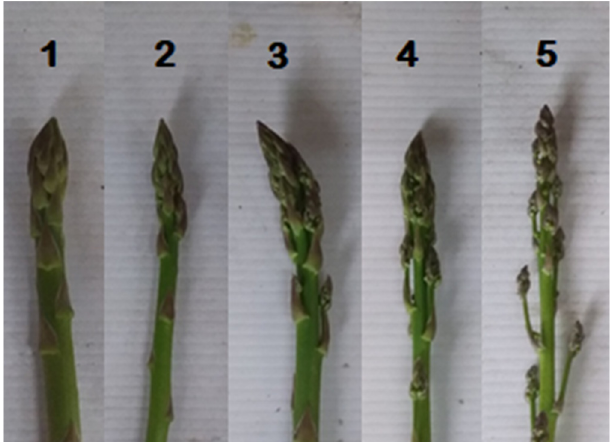
Figure 1. Scale 1 to 5 according to tip quality of the spears: 1 for tight heads, no lateral buds visible; 2 when small lateral buds were visible under the bracts; 3 when swollen lateral buds not yet elongated were present; 4 when lateral shoots elongated up to 1 cm were visible and 5 for branched spears.